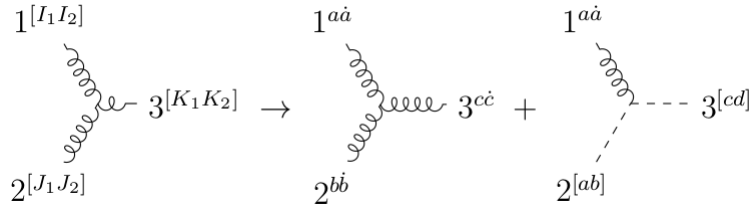
Figure 1 . High energy limit of 3-point massive vector